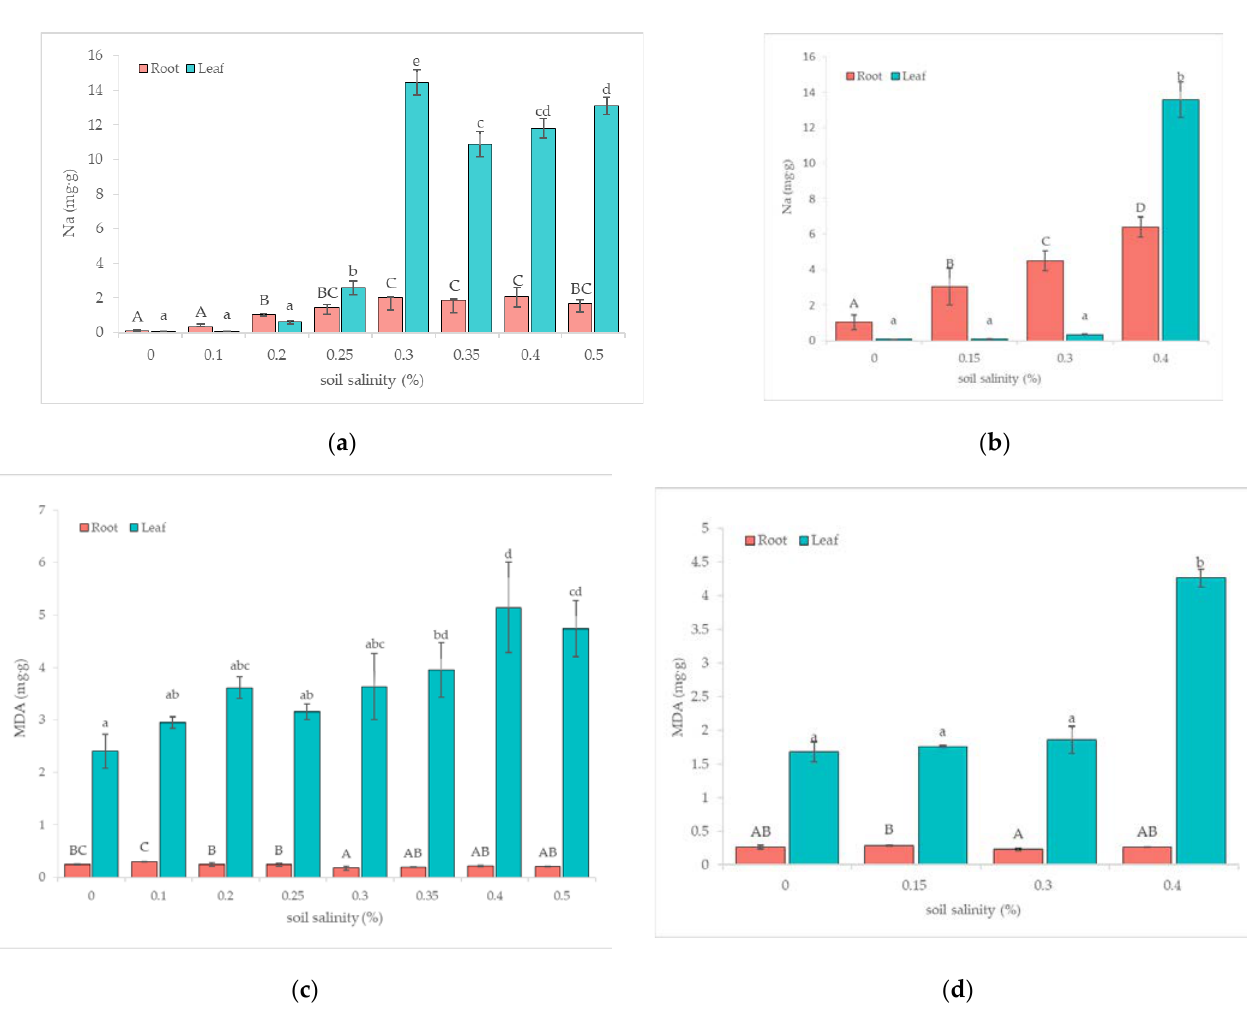
Figure 2. Sodium and MDA content in leaves and roots. Statistical analyses of roots and leaves were performed separately. Means with different letters indicate significant differences at the 0.05 level among the treatments. ( a ) Sodium content in leaves and roots of mulberry seedlings in C 1 . ( b ) Sodium content in leaves and roots of mulberry seedlings in C 2 . ( c ) MDA content in leaves and roots of mulberry seedlings in C 1 . ( d ) MDA content in leaves and roots of mulberry seedlings in C 2 .